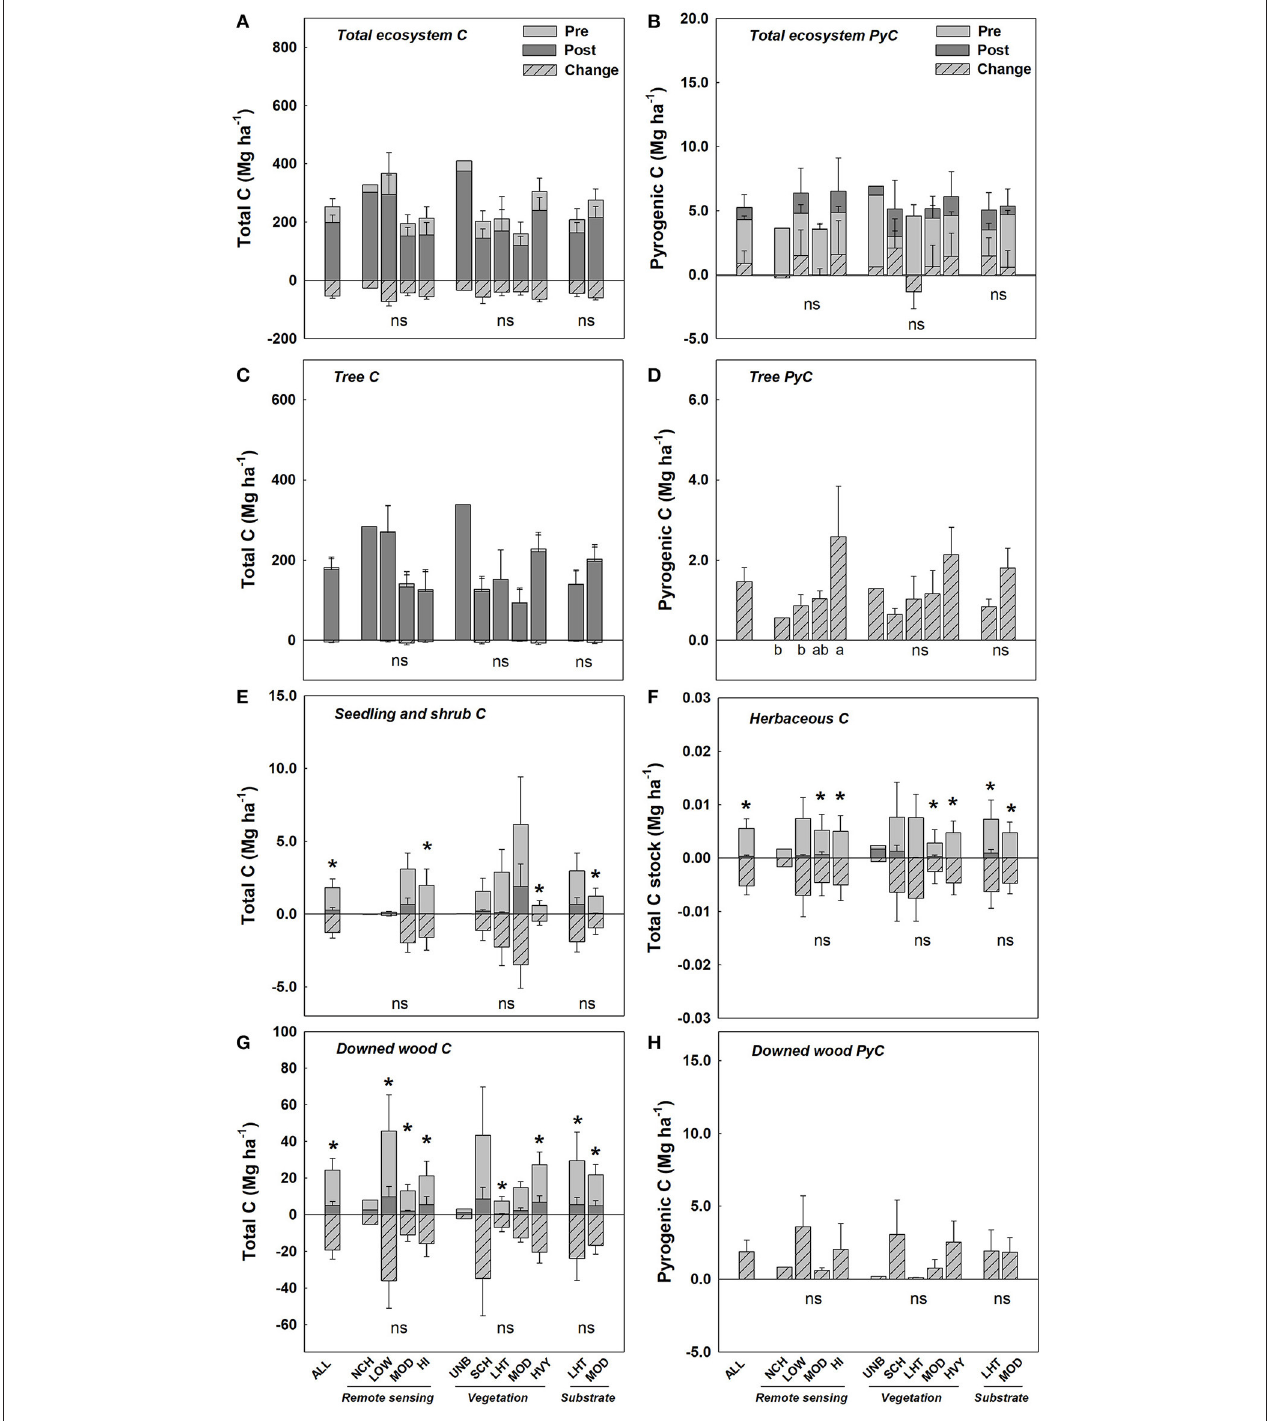
FIGURE 4 | Mean ( ± s.e.) total C and PyC stocks (Mg ha − 1 , estimated as PyC CTR via chemical oxidation) for total ecosystem carbon (A,B) , for the forest overstory (i.e., tree layer; C,D) ; seedling and shrub layer (C only; E) , herbaceous and grass layer (C only; F) , and downed wood (G,H) for pre-fire and post-fire conditions and calculated differences between pre- and post-fire measurements, shown for overall severity levels (ALL) and for plots classified by three fire severity classification systems. Because pre-fire PyC in bark and downed wood was assumed to be negligible, the post-fire PyC stocks in panels D and H are equivalent to the change (increase) in PyC for these forest components. Severity abbreviations follow those given in Figure 3 . Asterisks (*) indicate significant differences between pre- and post-fire measurements, within severity level. Lowercase letters below the zero line indicate significant differences in the change between pre- and post-fire measurements (hatched bars) among severity levels within classification system; ns indicates no significant differences ( p < 0.05). Differences among severity levels for pre-fire and for post-fire measurements are described in the text.